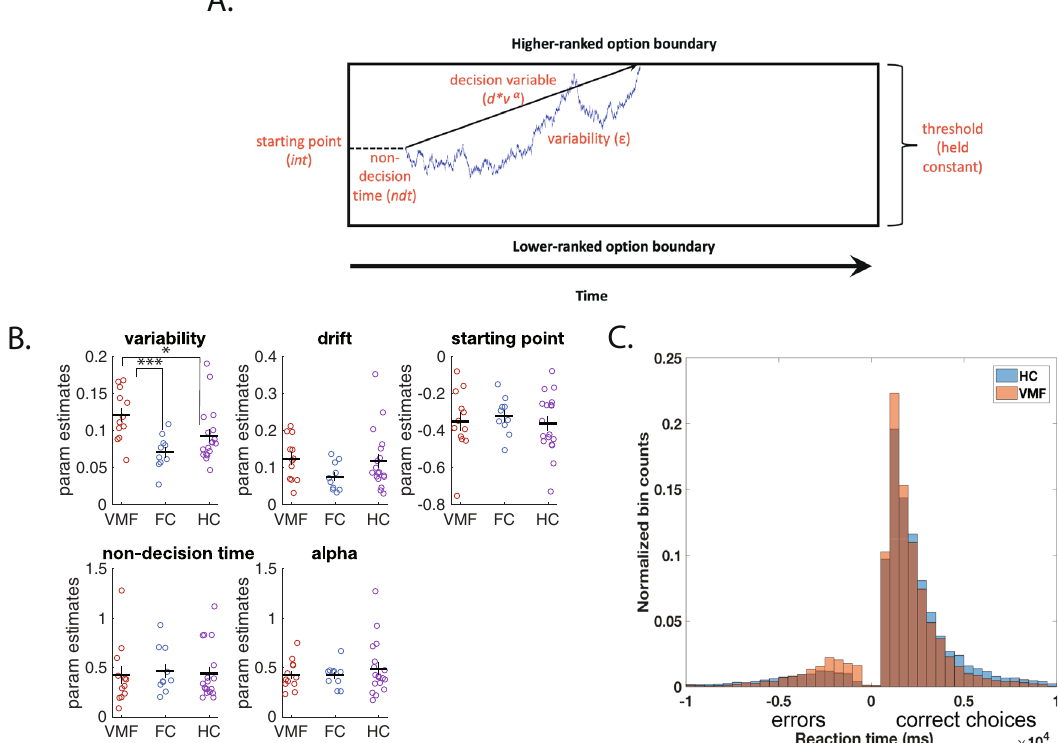
p =0.047, *** denotes p <0.001, two-tailed t -tests. N =40 individuals. VMF= Ventromedial Frontal group; FC=Frontal Controls; HC=Healthy Controls. C HistogramofreactiontimesofallchoicesbytheHCgroup(orange)andtheVMF group(blue).RTsof “ correct ” choices,choosingtheoptionwiththehigheraverage rank, are on the right, and RTs of “ errors ” , choosing the option with the lower average rank, are mirrored on the left). Source data for B and C are provided as a Source Data fi